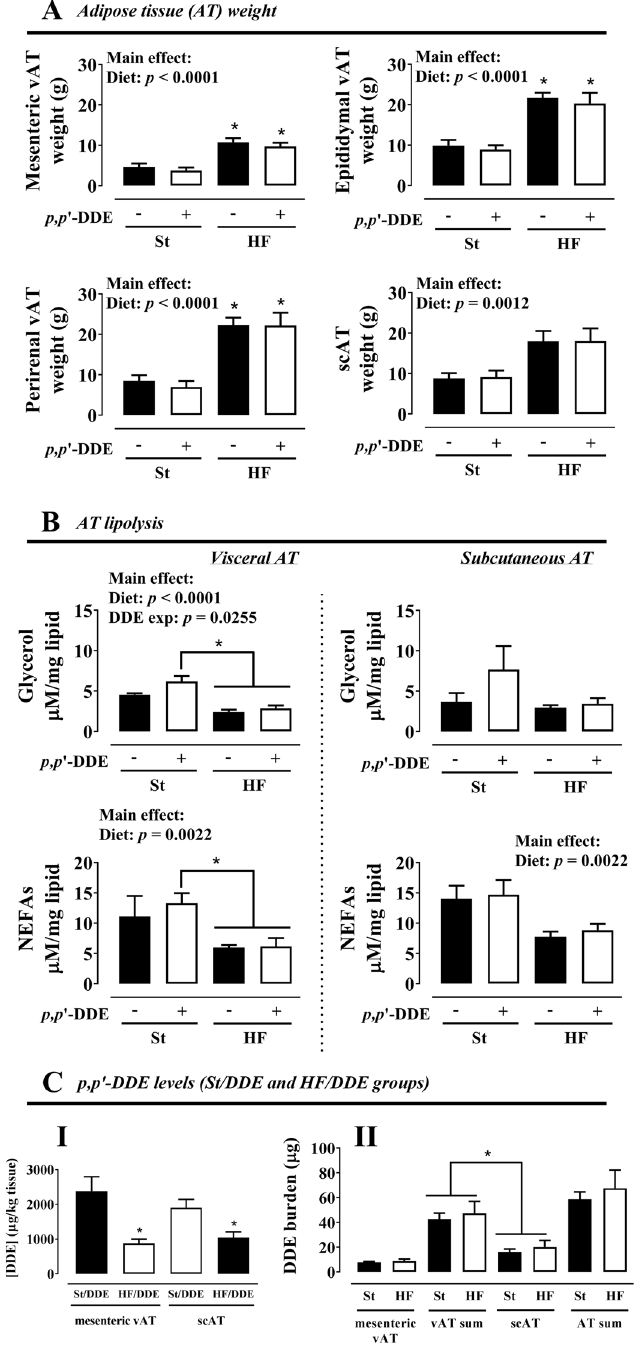
Figure 2. Adipose tissue (AT) depot weight ( A ), lipolysis in isolated mature adipocytes ( B ) and p , p ’-DDE levels in AT (concentration, CI ; burden, CII ), after 12 weeks. Values are represented as mean ± SEM. Statistical analysis with ( A , B ) two-way ANOVA (main effects: diet, p , p ’-DDE exposure and their interaction; p < 0.05), followed by Tukey’s multiple comparison post-hoc test: * p < 0.05 vs St and/or St/DDE; ( C ) unpaired t test when comparing between treatment groups (St/DDE and HF/DDE) and paired t test when comparing between different ATs from the same treatment group: * p < 0.05. St, standard diet; HF, high fat diet; p , p ’-DDE, p , p ’-dichlorodiphenyldichloroet hylene; vAT, visceral adipose tissue; scAT, subcutaneous adipose tissue; NEFAs, non-esterified fatty